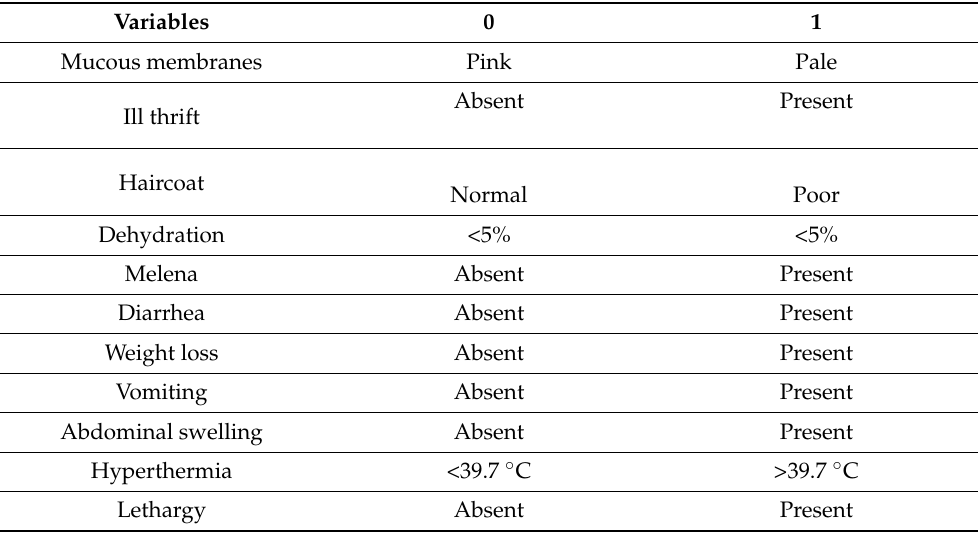
Table 1. The scoring system for the clinical assessment of included dogs. Variables 0 1 Mucous